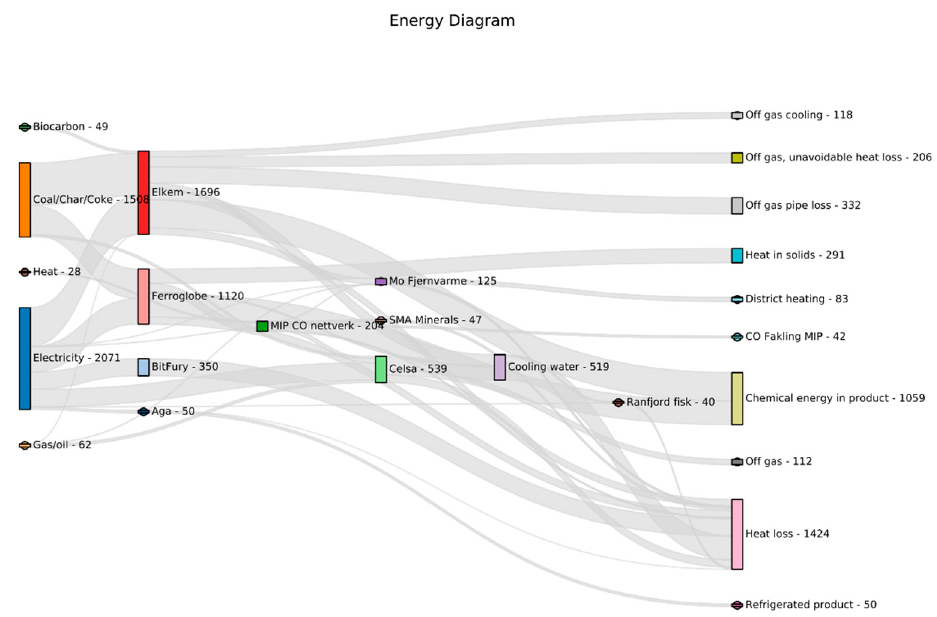
Figure 3. Sankey diagram for annual energy flows (GWh). See Table A3 in Appendix A for aggregated energy flow data across battery limits at Mo Industrial Park.